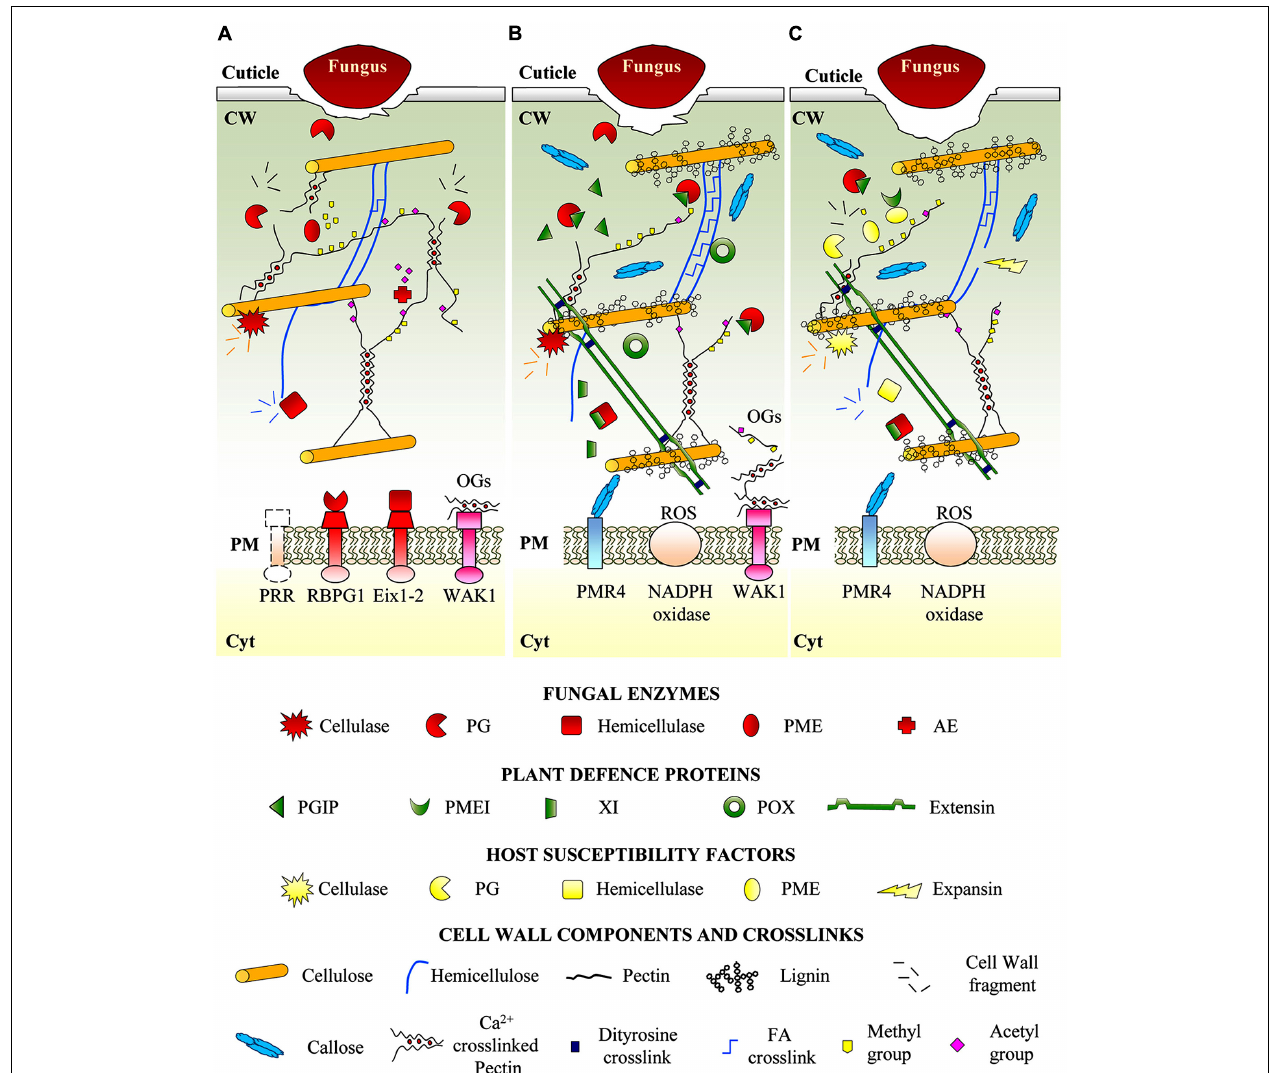
FIGURE 1 | Cell wall dynamics during necrotrophs invasion. (A) Necrotrophic fungi secrete a large arsenal of cell wall degrading enzymes (CWDEs) like PGs, hemicellulases and cellulases, assisted by PMEs and AEs in the apoplastic space to degrade cell wall polymers and facilitate the availability of nutrients. PGs and EIXs have been proposed to function as PAMPs recognized by the membrane receptors RBPG1 and Eix1 or 2, respectively. (B) As first line of defense, plants produce a variety of CWDE inhibitors to hinder degradation by microbial CWDEs. For instance, the inhibition of PG degrading activity by PGIPs induces the accumulation of elicitor-active pectin fragments (OGs) perceived by